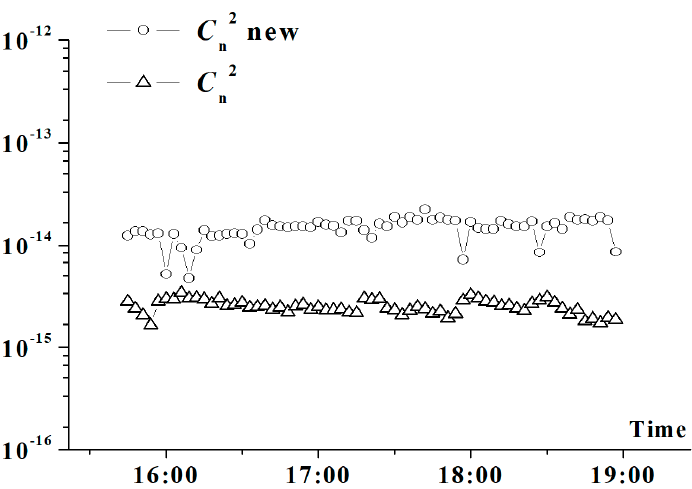
Figure 6. Comparison of experimental measurements of the structural characteristics of C n 2 using the conventional algorithm of ultrasonic anemometers and the new improved algorithm. Sayan, August 2018.